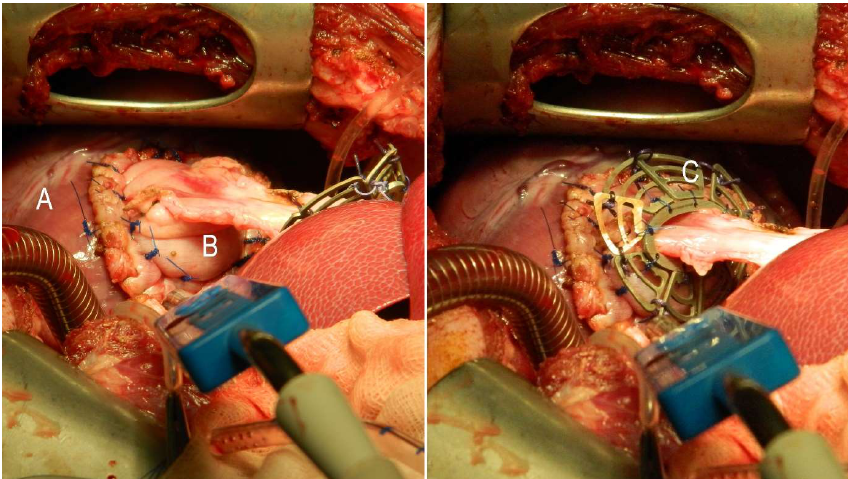
Figure 1. Operative situs. Autologous transplantation of a vascularized stomach segment (B) to reconstruct a complete wall defect of the left ventricle (A) in a porcine model. Stabilization of the delicate stomach tissue with a degradable magnesium alloy scaffold (C).